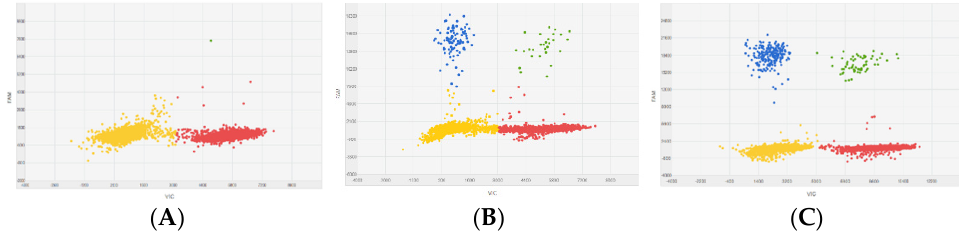
Figure 2. Scatterplots for Y chromosome detection in simulated MCC. Scatterplots representing fluorescence signals from probe targeting chromosome Y (FAM reporter dye) and probe targeting reference chromosome (VIC reporter dye) ( A ) detection of Y chromosome in 100% of simulated MCC, ( B ) detection of Y chromosome in 95% of simulated MCC, and ( C ) detection of Y chromosome in 92% of simulated MCC. The yellow dots represent wells without signal (no amplification), the green dots represent wells with FAM and VIC signal, the blue dots represent wells with a FAM signal, and the red dots represent wells with a VIC signal.